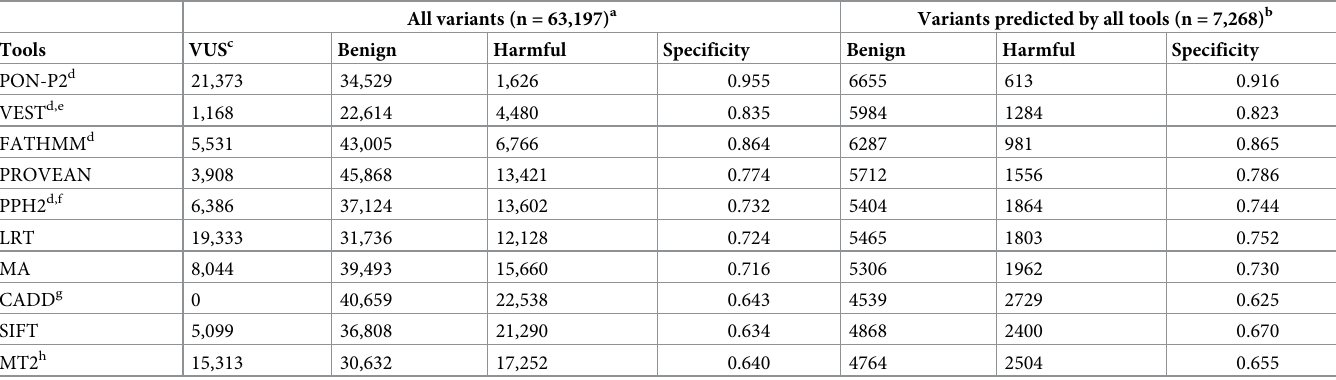
Table 1. Specificities of variant interpretation